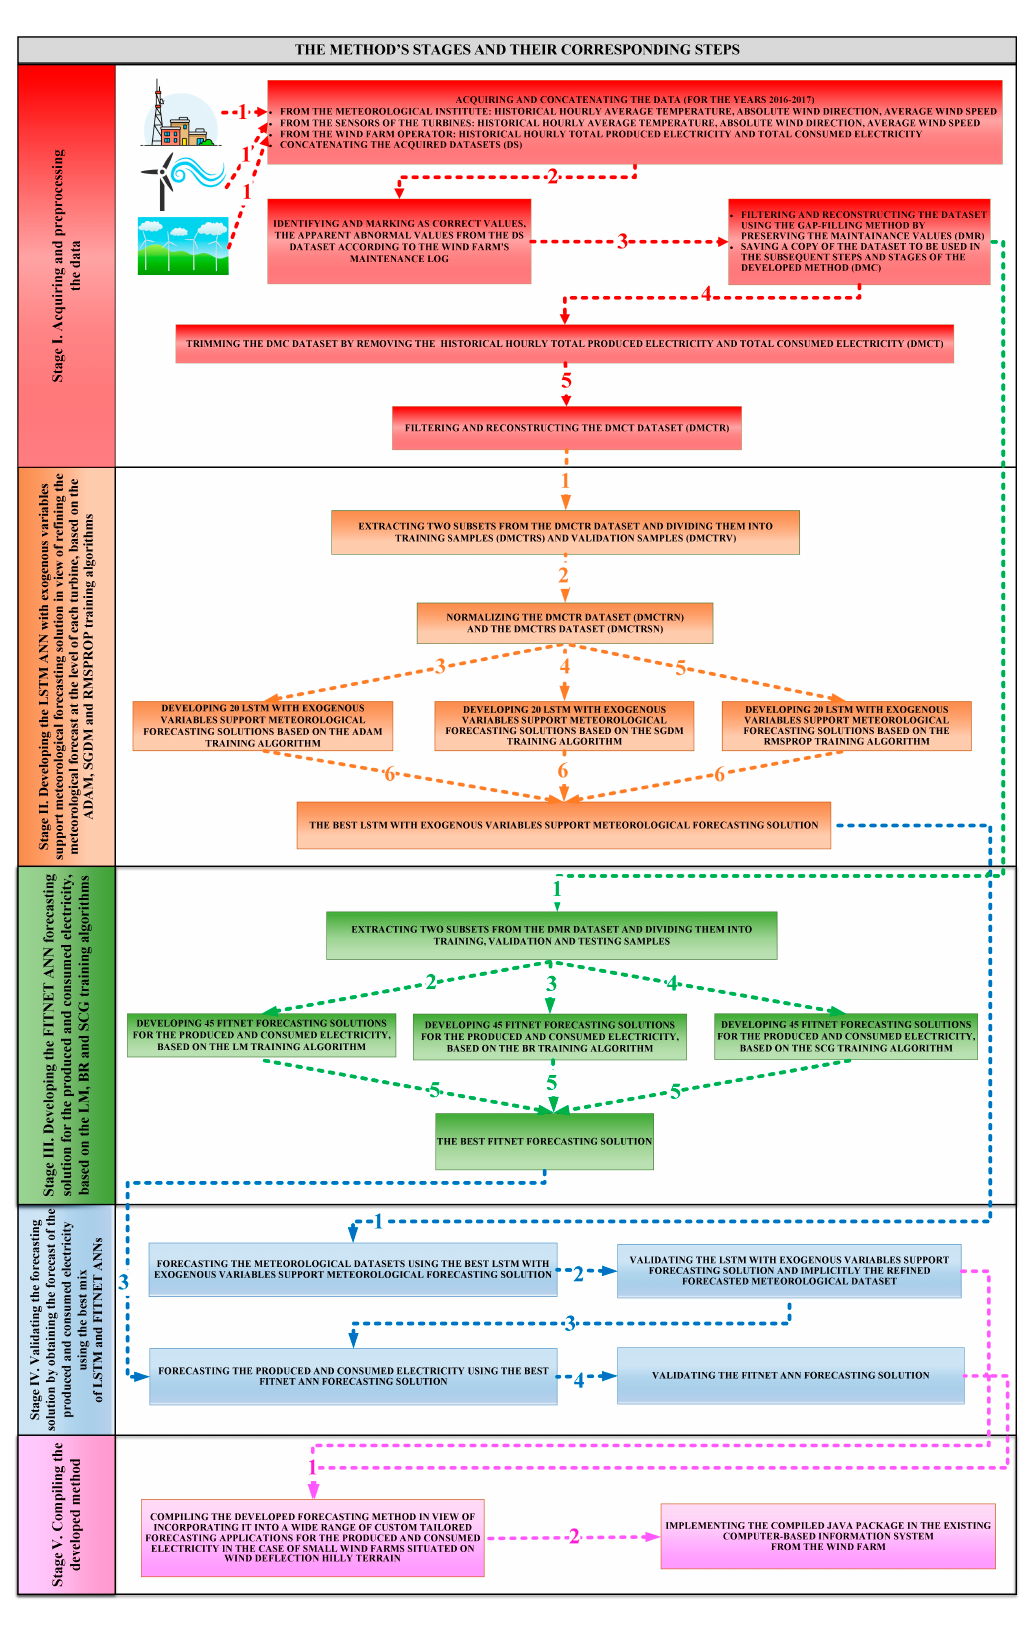
Figure 2. The flowchart of the devised forecasting method.